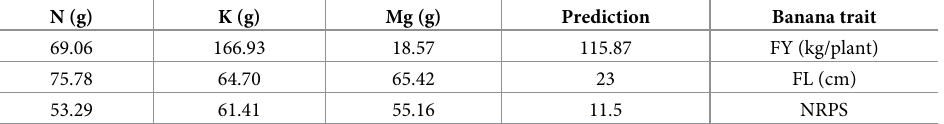
Table 3. Optimizing amounts of N, K, and Mg fertilizers based on genetic algorithm for maximizing fruit yield (FY), fruit length (FL), and number of rows per spike (NRPS)soybean seed